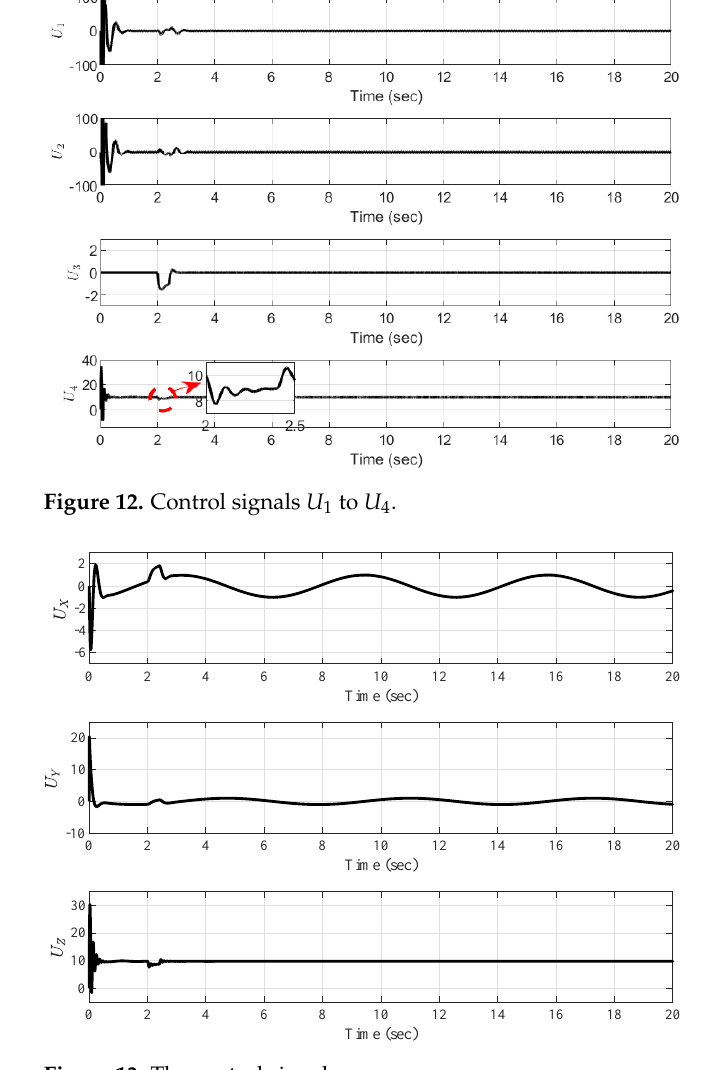
Figure 13. The control